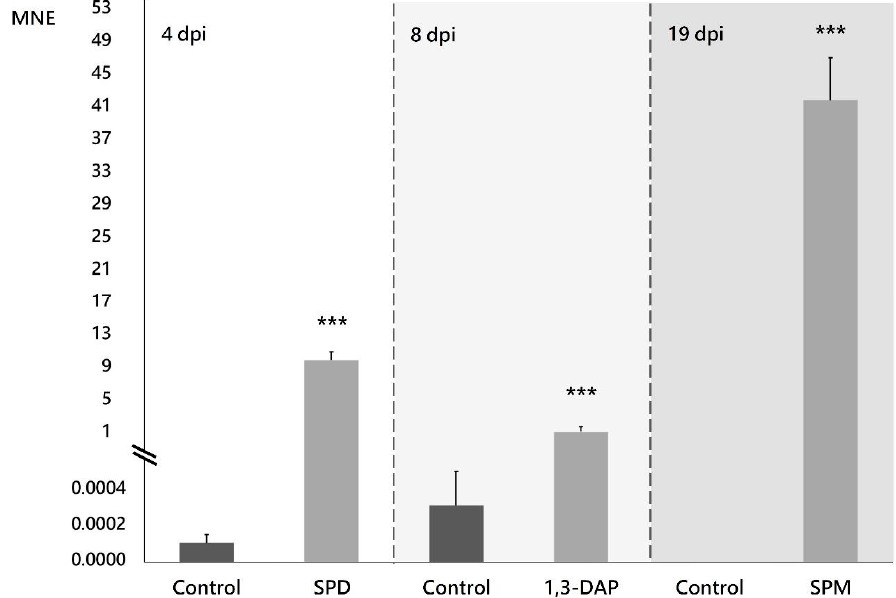
Figure 3. Expression of the Bcnrps 1 gene (MNE) of B. cinerea B05.10 on the days when the highest expression levels were recorded in PAs-supplemented medium compared to control. Malt extract fermentation without PAs (control) is represented with gray bars, and fermentation supplemented with PAs with light gray bars. dpi: days post inoculation. Error bars represent standard deviations of means ( n = 3). Asterisks indicate significant differences, according to t -test ( p -value < 0.001, ***).